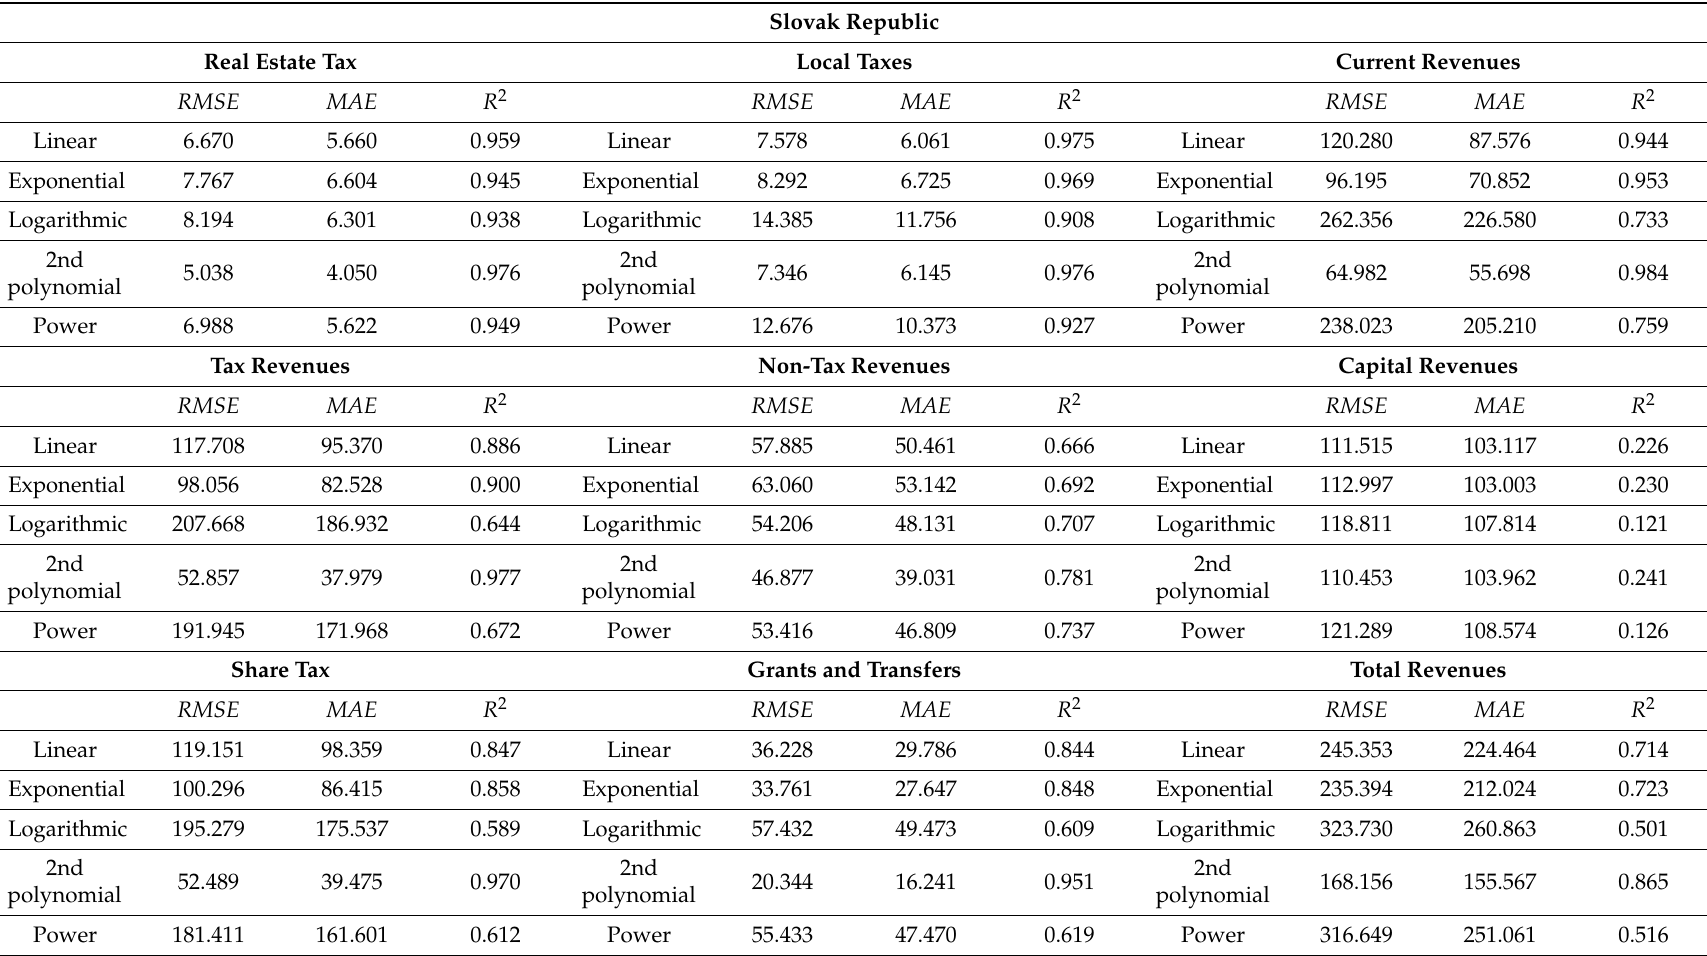
Table 7. Trend functions of selected revenues of the municipalities in Slovak